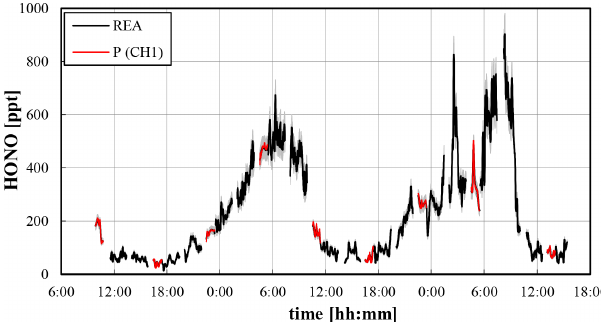
Figure 3. Weighted average HONO concentration determined from both channels during REA measurements (REA) and HONO con- centration from channel 1 during parallel ambient measurements (P (CH1)) for the test campaign at the university of Wuppertal (30s data, 5min running mean). The grey shaded area reflects the accu- racy of the